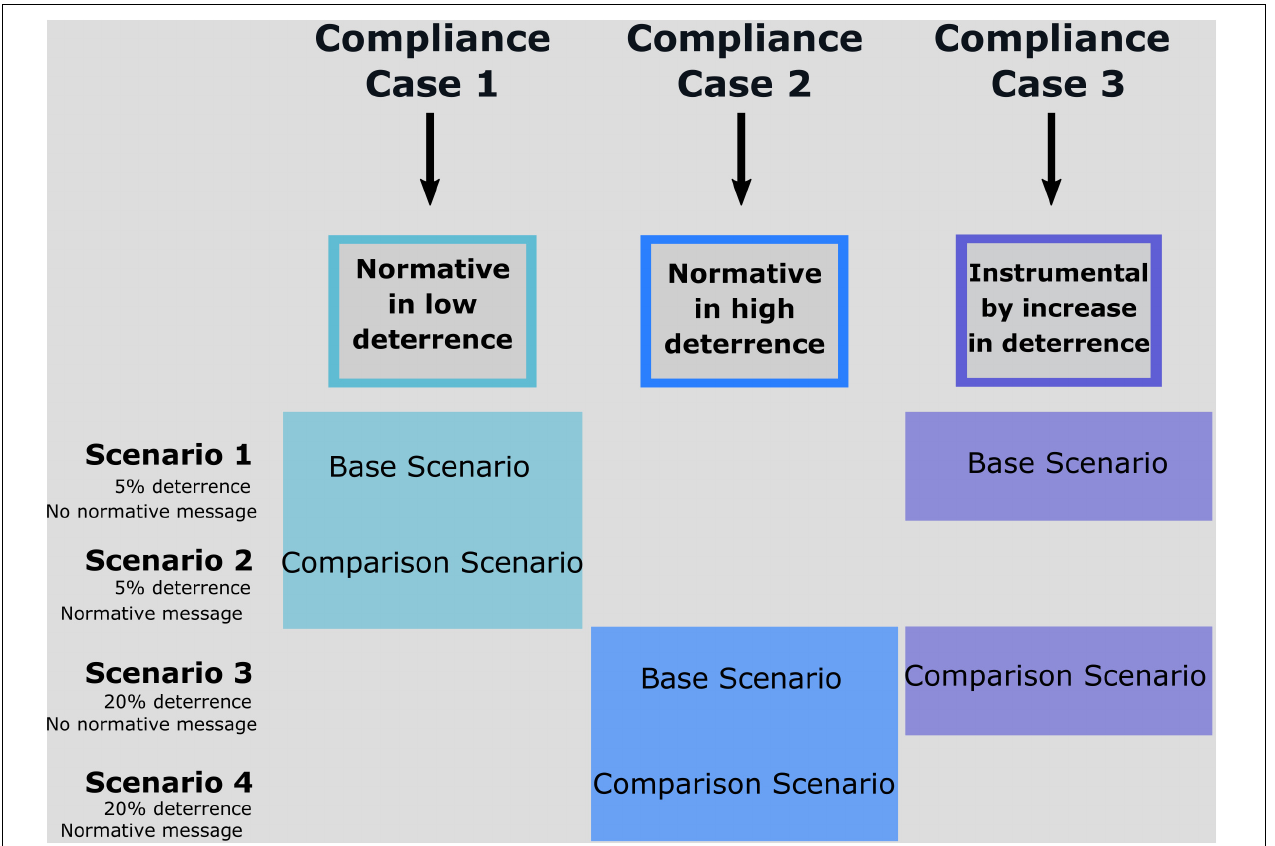
FIGURE 2 | Fishery compliance cases. Using the four experimental fishery scenarios three compliance cases are defined by comparing compliance decisions in a base scenario and a comparison scenario. The three compliance cases are: (1) normative incentive in a low deterrence context, (2) normative incentive in a high deterrence context, and, (3) an instrumental incentive via an increase in